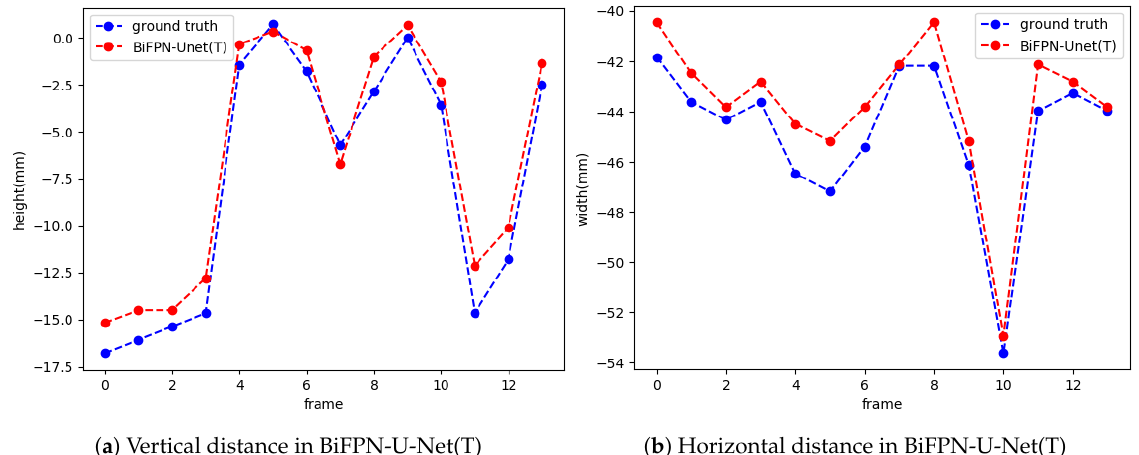
Figure 8. Visualization of distance measurements by hyoid bone tracking for a